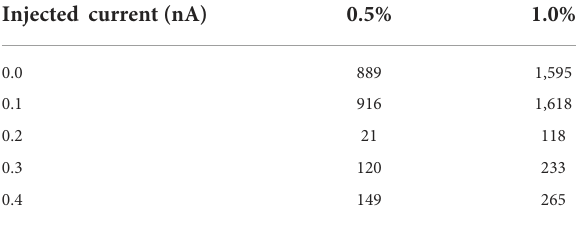
TABLE 4 Number of solutions given the injected current as a function of percentage difference from the best solution. Injected current (nA) 0.5%